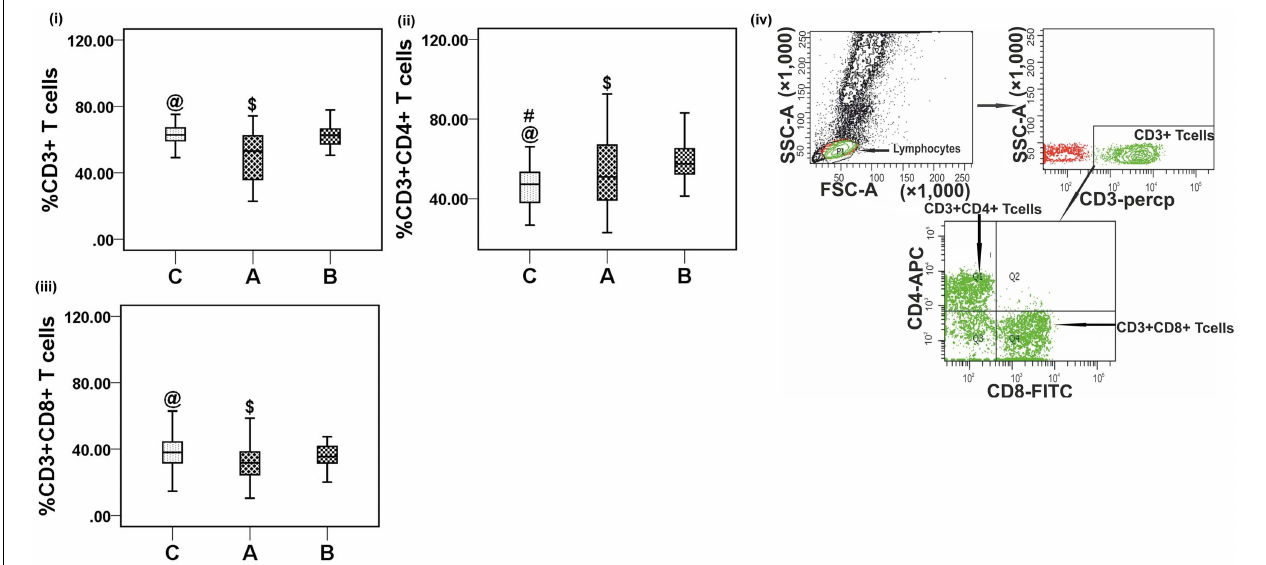
FIGURE 5 | Distribution of CD3 + , CD3 + CD4 + and CD3 + CD8 + T cells. Percentages of the lymphocytes mentioned were determined from the whole blood of 36 control (represented by “C”) subjects, 45 acute (represented by “A”), and 31 convalescent (represented by “B”) patients. Box plots show the percetage of (i) CD3 + T cells, (ii) CD3 + CD4 + T cells, and (iii) CD3 + CD8 + T cells. Kolmogorov–Smirnov test was used for intergroup comparison. p < 0 . 05 is considered significant. (iv) Plots showing the strategy used for gating lymphocytes, CD3 + T, CD3 + CD4 + T, and CD3 + CD8 + T cells. Lymphocytes are gated in FSC vs. SSC plot, CD3 + T cells were gated within the lymphocytes population, CD3 + CD4 + and CD3 + CD8 + T cells were gated on CD3 + T cells. Contour plot shows CD3 + T cell gating, upper left quadrant (Q1) of the contour plot shows CD3 + CD4 + T cells and lower right quadrant (Q4) shows CD3 + CD8 + T